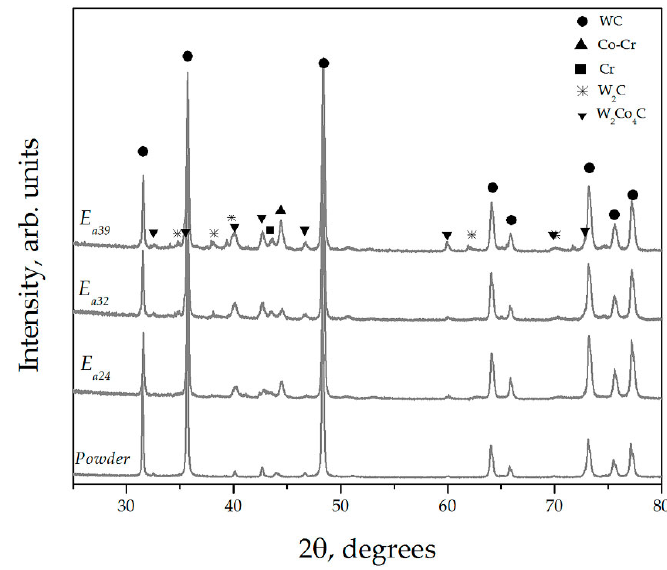
Figure 6. XRD patterns of the powder feedstock and the laser cladding samples deposited using different average energy.